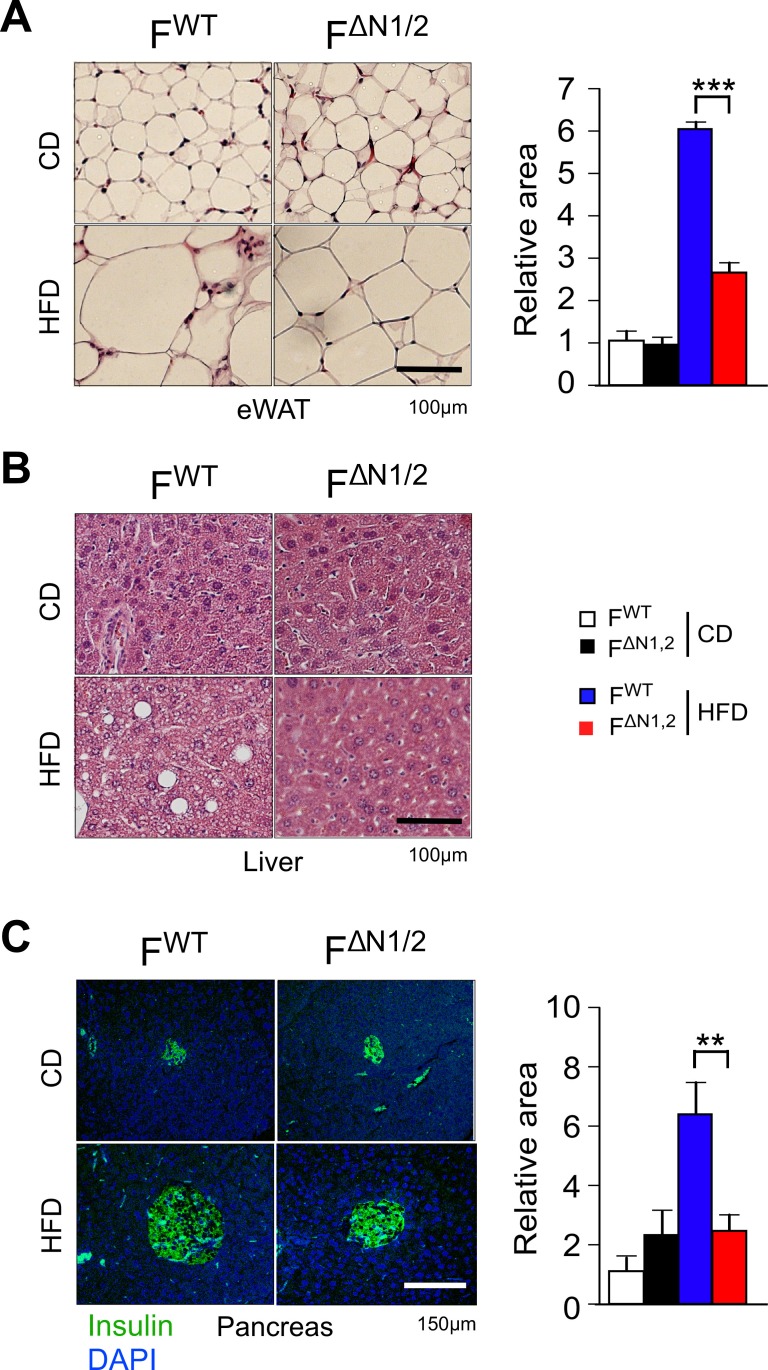
Comparison of adipose tissue, liver, and pancreas in FWT and F∆N1,2 mice.(A) Analysis of hematoxylin & eosin-stained tissue sections prepared from epididymal adipose tissue of CD-fed and HFD-fed (16 wk) FWT and F∆N1,2 mice. The relative area of adipocytes is presented (mean ± SEM; n=6 mice). (B) Representative hematoxylin & eosin-stained liver sections are presented (n=6). (C) Sections of the pancreas were stained with an antibody to insulin (green). DNA was stained with DAPI. The relative area of islets is presented (mean ± SEM; n=6 mice). Statistically significant differences between FWT and F∆N1,2 mice are indicated: **p<0.01; ***p<0.001.